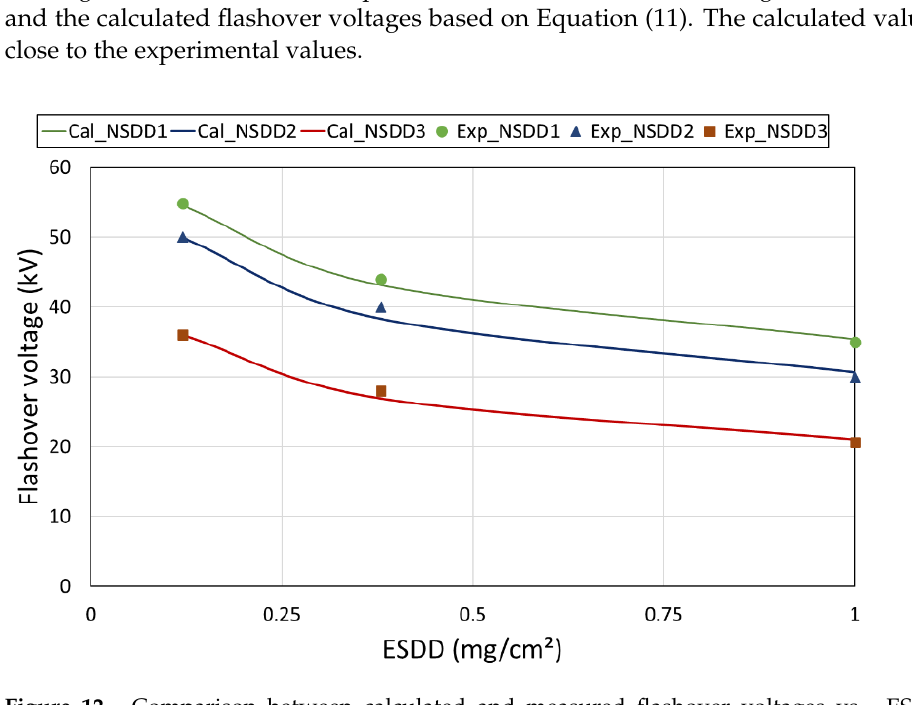
Figure 12. Comparison between calculated and measured flashover voltages vs. ESDD for various NSDD.